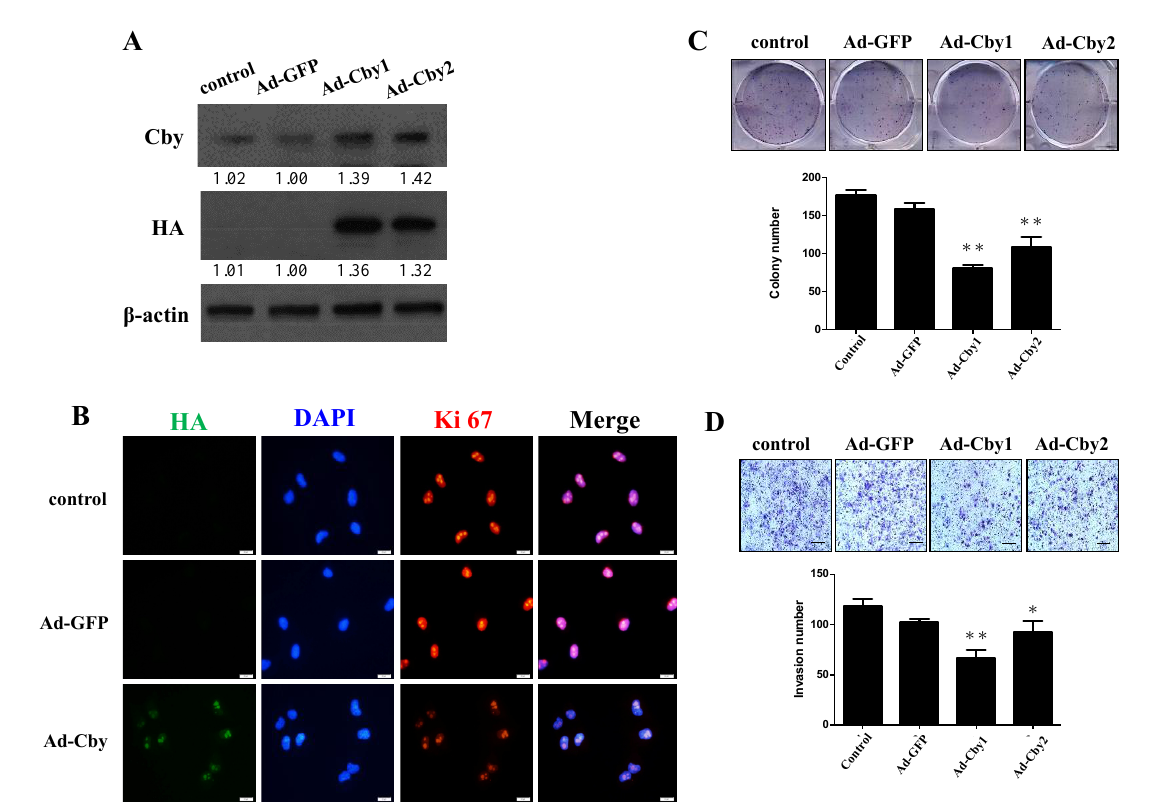
Figure 5. Overexpression of Chibby expression inhibits cell proliferation and invasion of HCC cells. ( A ) Adenovirus-mediated ectopic expression of Chibby and enhanced the expression of Chibby in Huh7 cells. After 48 h of infection with adenoviral vectors (Ad-GFP or Ad-Chibby) at di ff erent multiplicity of infection, the protein lysates from the Huh7 cells were harvested to determine the ectopic gene expression using Western blot analysis. Ad-GFP was designed as the control vector. ( B ) Representative immunofluorescent images of Ki67 in Huh7-normal control, Huh7-Ad-GFP, and Huh7-Ad-Chibby cells. ( C , D ) The enhancement of Chibby in Huh7 cells transfected with Ad-Chibby suppressed cell proliferation and invasiveness by colon-formation assay and the Boyden chamber system, respectively. Data represent mean ± SE from three independent analyses. Scale bar, 100 µ m, * p < 0.05 and ** p < 0.01 vs. Ad-GFP